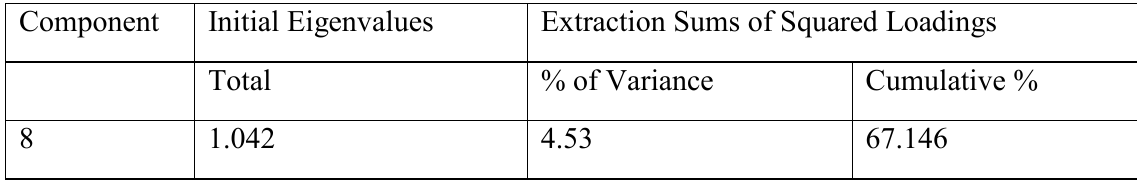
Table 1.53: Variance explained for Transformative Resilience PC8